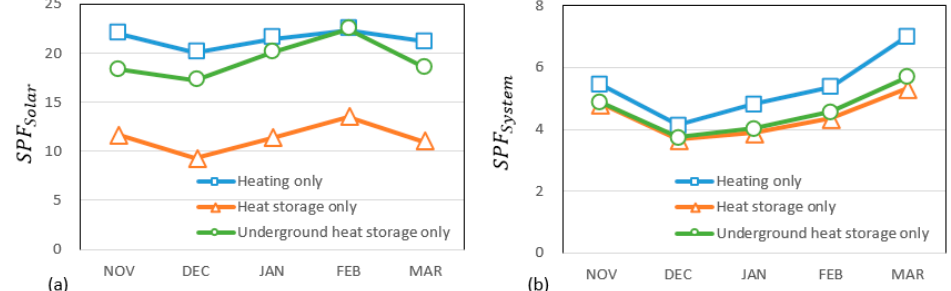
Figure 36. The result of SPF considering change method of using solar heat. ( a ) PVT; ( b ) total systems.